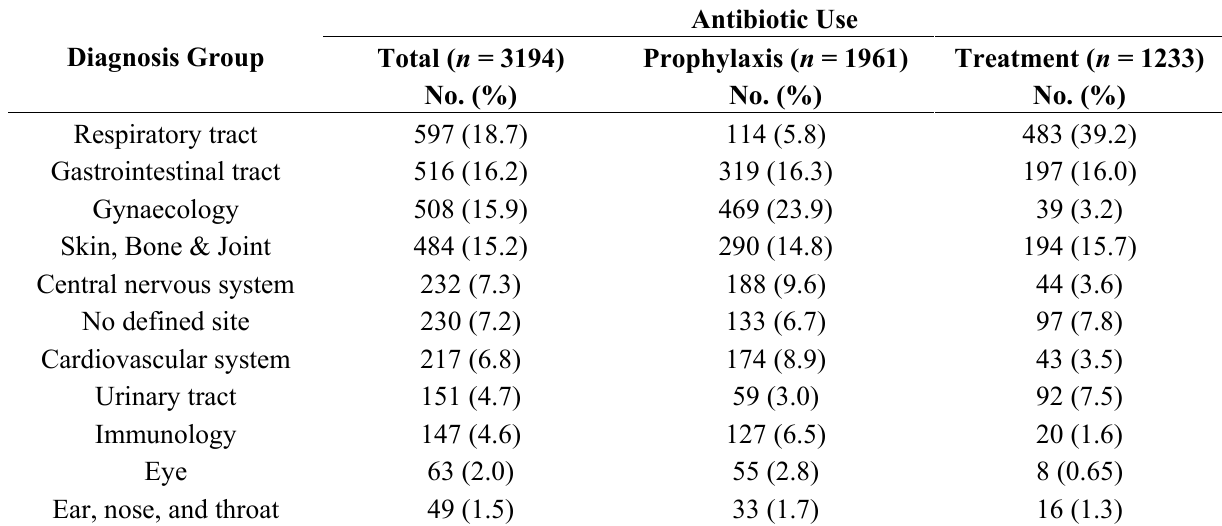
Table 3. Distribution of Antibiotic Treatment and Prophylaxis by